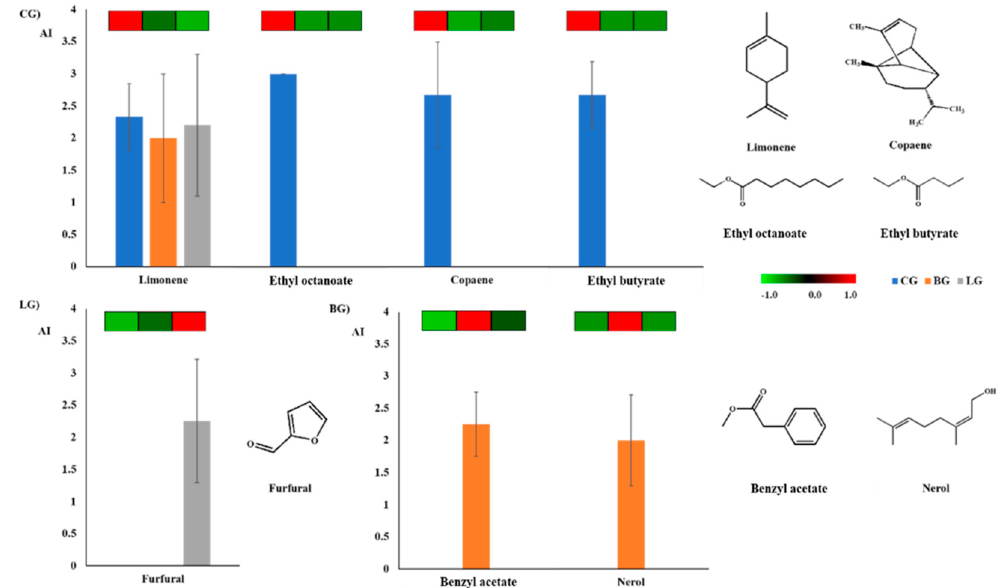
Figure 5. The GC-O / MS aroma intensity and abundance heat map in GC × GC-TOFMS analysis of key aroma compounds in three citrus blend black tea groups. CG: Citrus Group; BG: Bergamot Group; LG: Lemon Group.